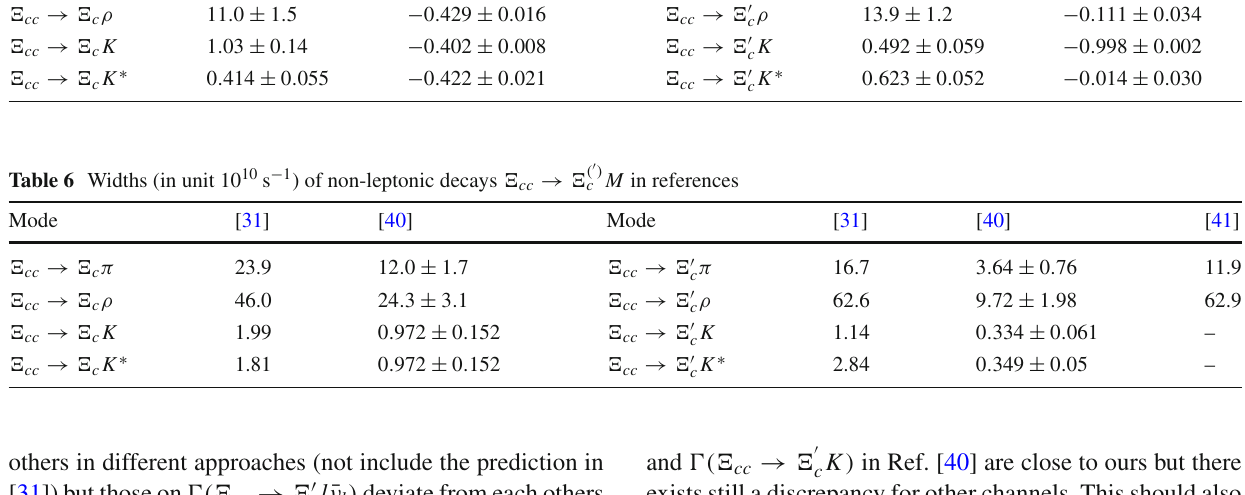
Table 5 Our predictions on Widths (in unit 10 10 s − 1 ) and up-down asymmetry of non-leptonic decays (cid:2) cc → (cid:2) ( Mode Width Up-down asymmetry Mode Width